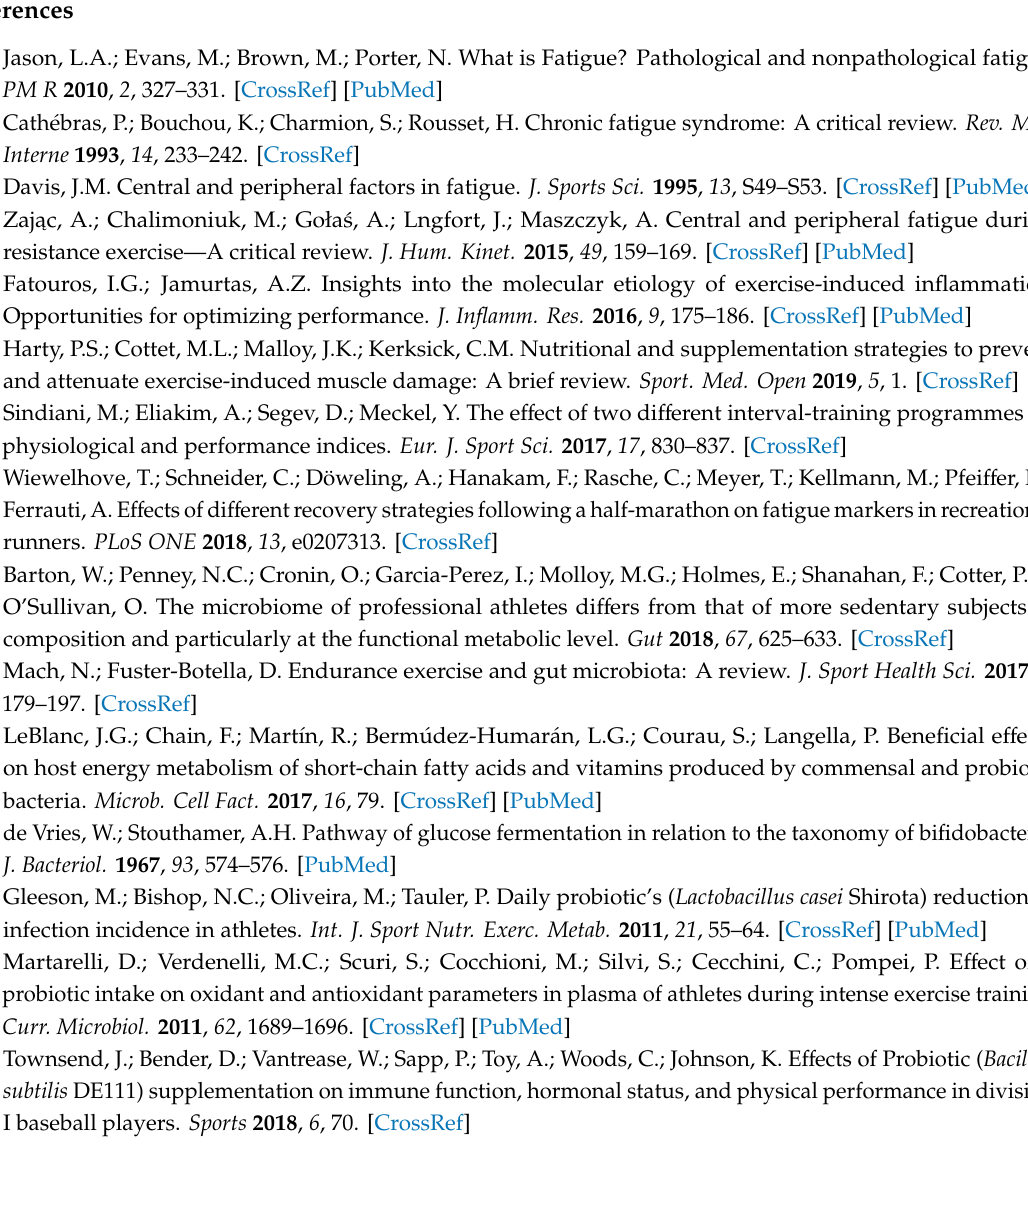
Figure S1: Blood biochemical profiles in the di ff erent time points of the subjects before the administration of TWK10: (A) AST; (B) ALT; (C) BUN; (D) Creatinine; (E) UA; (F) Free fatty acids; (G) Glycerol. 0, time zero; E30, exercise for 30 min; R90, resting 90 min after exercise. Statistical di ff erence among groups was analyzed by Tukey–Kramer test at the same time point. Figure S2: Blood biochemical profiles in the di ff erent time points of the subjects after the administration of TWK10: (A) AST; (B) ALT; (C) BUN; (D) Creatinine; (E) UA; (F) Free fatty acids; (G) Glycerol. 0, time zero; E30, exercise for 30 min; R90, resting 90 min after exercise. Statistical di ff erence among groups was analyzed by Tukey–Kramer test at the same time